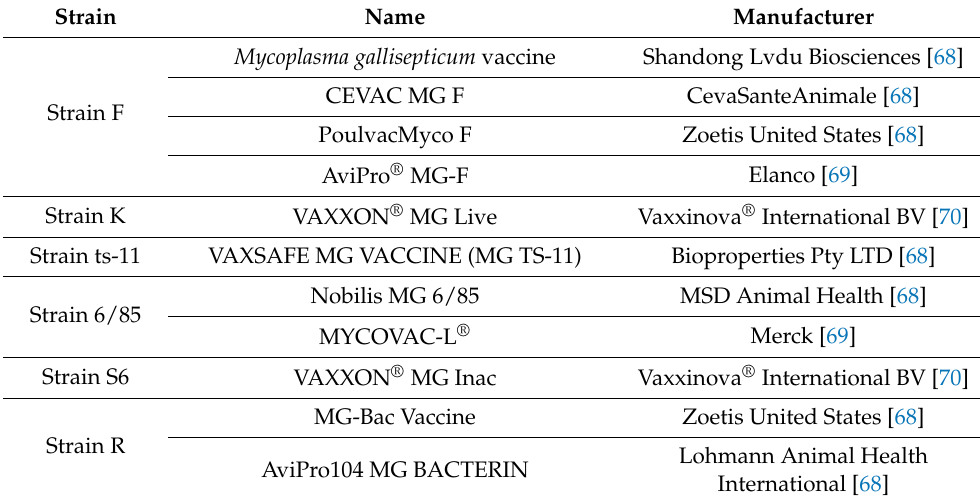
Table 2. Examples of commercially available vaccines against M. gallisepticum .